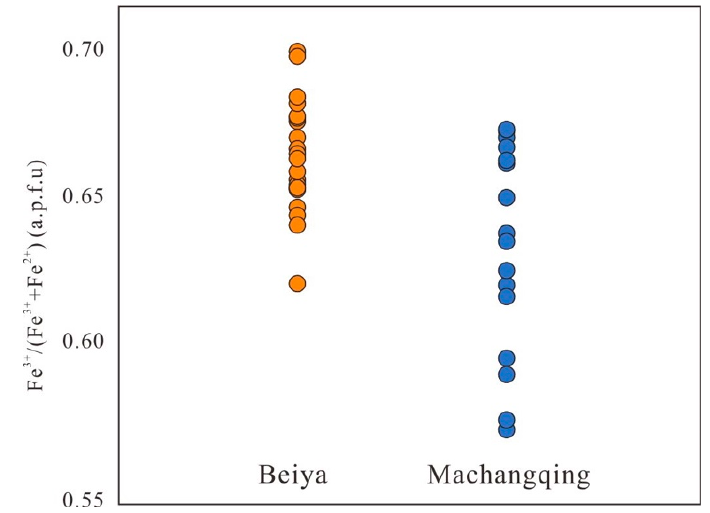
Figure 11. Fe 3+ /(Fe 3+ + Fe 2+ ) ratios of allanite from the Beiya and Machangqing deposits.